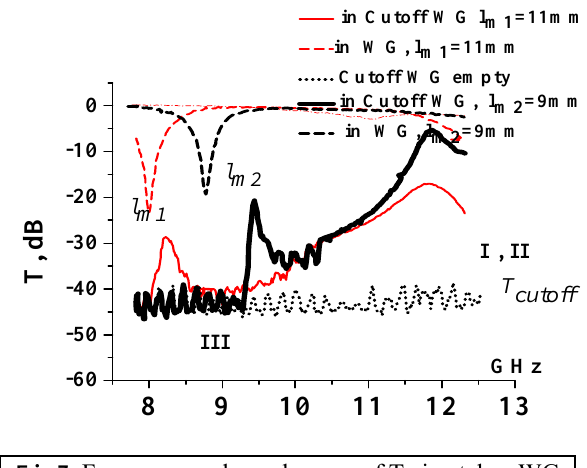
Fig.7. Fre quency dependences of T i n t he WG (dashed) and cuto ff WG (s olid) in t he presence of metastructure “ Grating -longitudinal c ut-wire” wi th